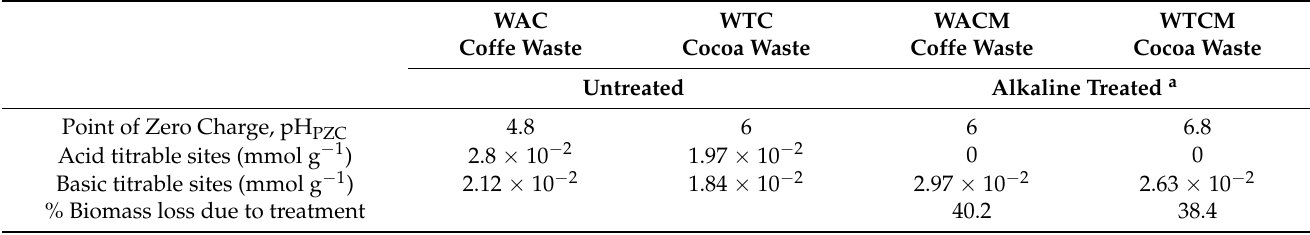
Table 1. Physical–chemical characteristics of untreated and alkaline treated Arabica -coffee and Theobroma -cocoa wastes. WAC WTC WACM WTCM Coffe Waste Cocoa Waste Coffe Waste Cocoa Waste Untreated Alkaline Treated a